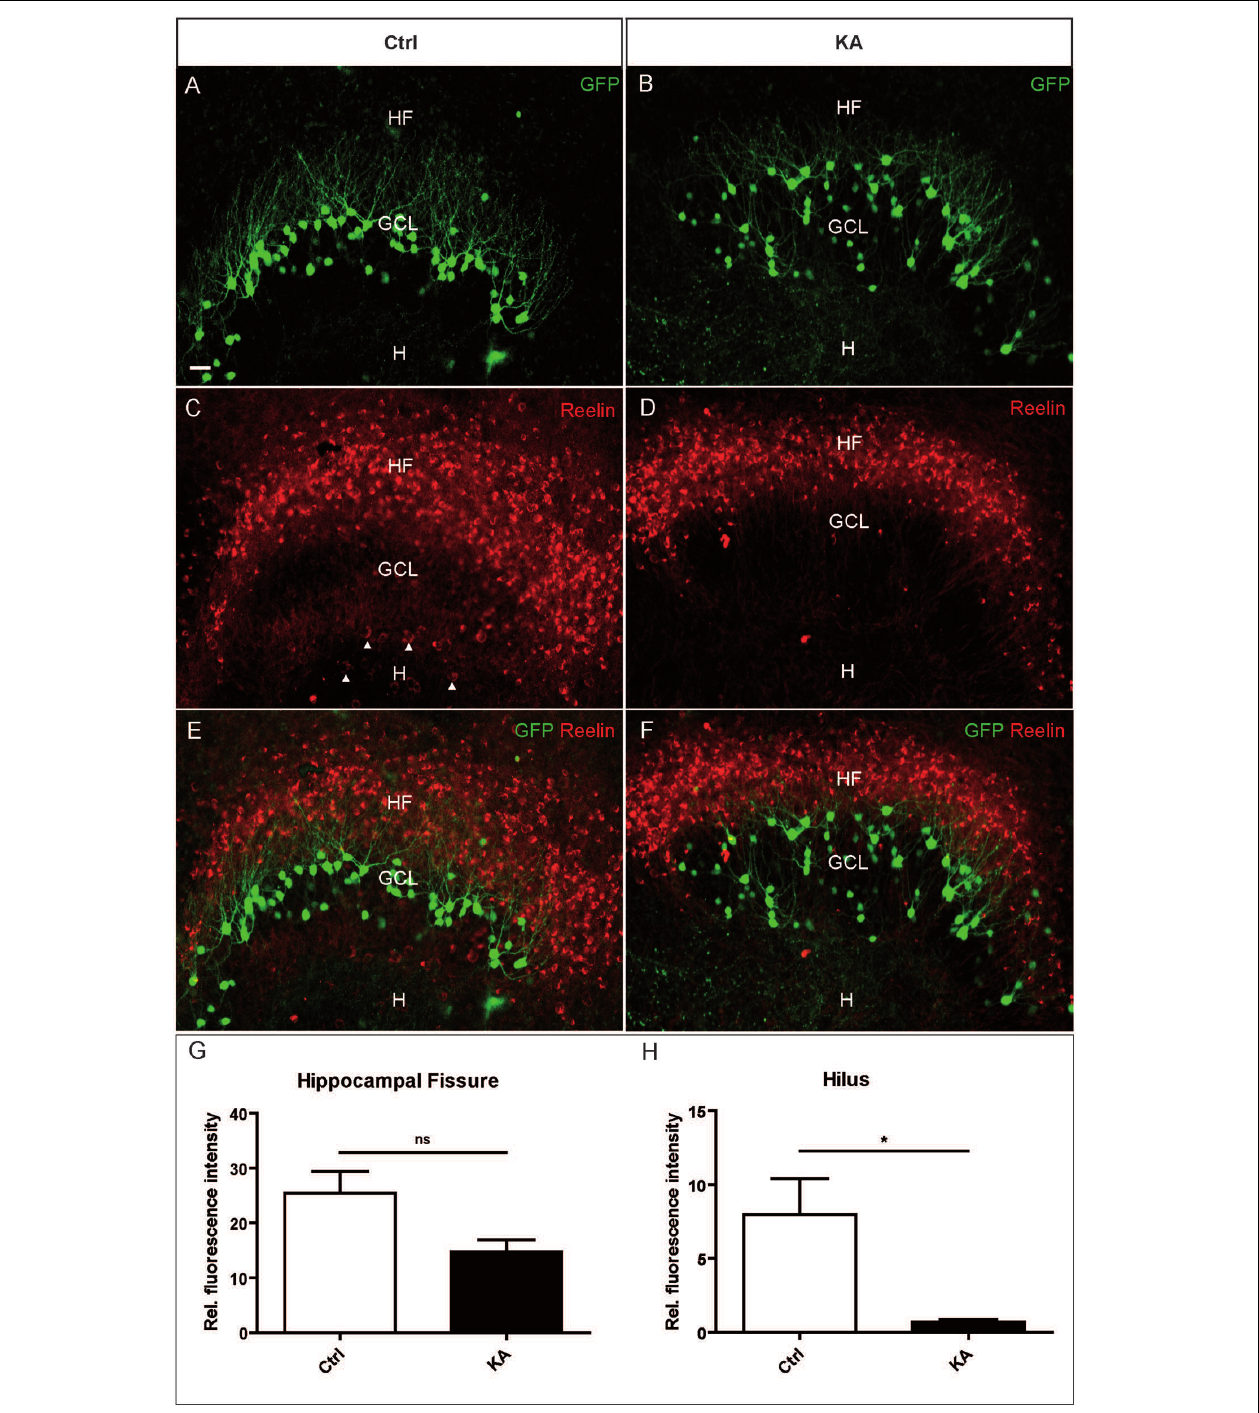
FIGURE 2 | Loss of Reelin-positive neurons in the hilus after KA treatment in OHSC. Representative confocal images of whole OHSC from Thy1-eGFP (enhanced green fluorescent protein; green) mice immunolabeled for Reelin (red). (A,C,E) Control. (B,D,F) OHSC, 8 h after KA application for 45 min. In the control, eGFP-positive granule cells are arranged in a compact layer (A) but appear dispersed after KA treatment (B) . (C,D) Immunolabeling for Reelin. Many strongly immunostained Reelin-expressing neurons are visible at the HF, and large Reelin-immunopositive neurons are located in the hilus (arrow heads, C ). Note the loss of Reelin-positive hilar interneurons after KA treatment (D) . (E,F) Overlay of eGFP (green) and Reelin (red) signals. (G,H) Densitometric quantification of the Reelin signal at the HF (G) and in the hilus (H) in controls ( n = 4) and after KA treatment ( n = 4). Unpaired student’s t -test ( ∗ P < 0.05, ns with P = 0.057). GCL, granule cell layer; H, hilus; HF, hippocampal fissure. Scale bar: 10 µ